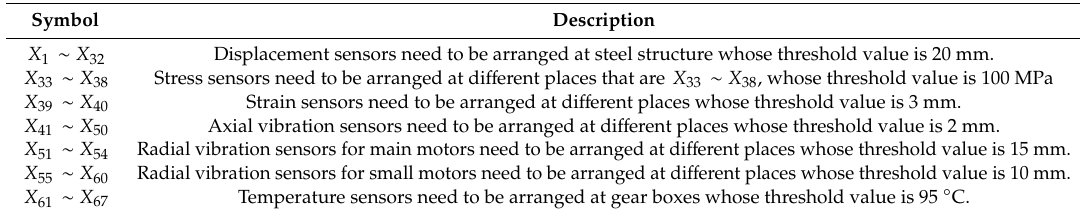
Table 1. Sensors installed in each equipment.